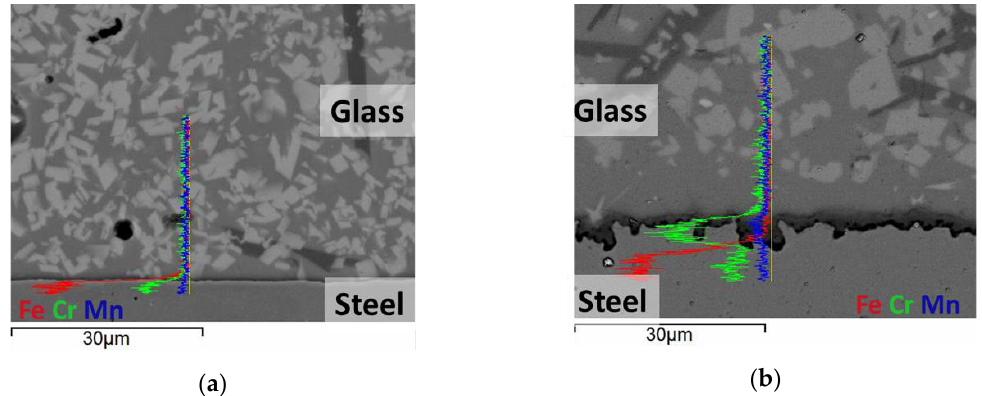
Figure 5. SEM-BSE cross-section image and EDX line scans of the sample ( a ) before aging and ( b ) aged for 250 h at 780 ◦